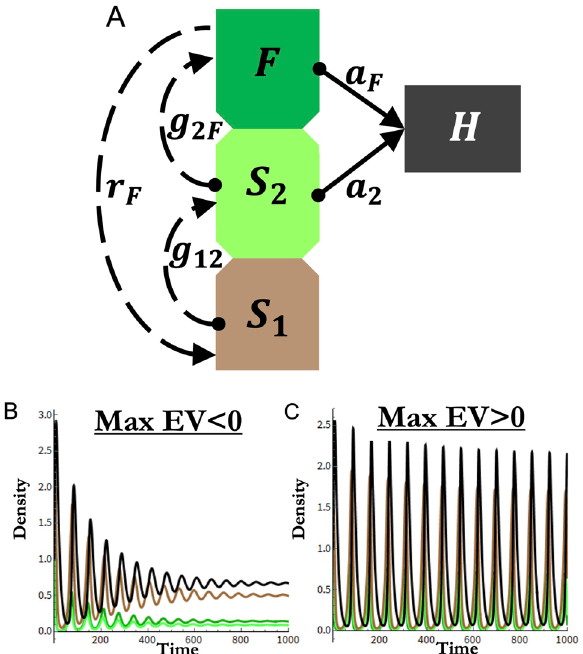
Figure 1. Simulation model overview. ( A ) Model diagram and major parameters mediating model flow. Dashed lines indicate plant population dynamics, solid lines indicate trophic interactions. S 1 indicates seed density, S 2 indicates seedling density, F indicates fecund adult density, H indicates density of herbivorous insects. Arrows indicate direction of density gain and circles indicate direction of density loss. Parameters detailed in “Methods” and Table 1. ( B ) Example of stable population trajectories indicated by negative max eigenvalue (Max EV < 0). ( C ) Example of persistent population oscillations indicated by positive max eigenvalue (Max EV > 0). Line colors for ( B ) and ( C ) correspond to ( A